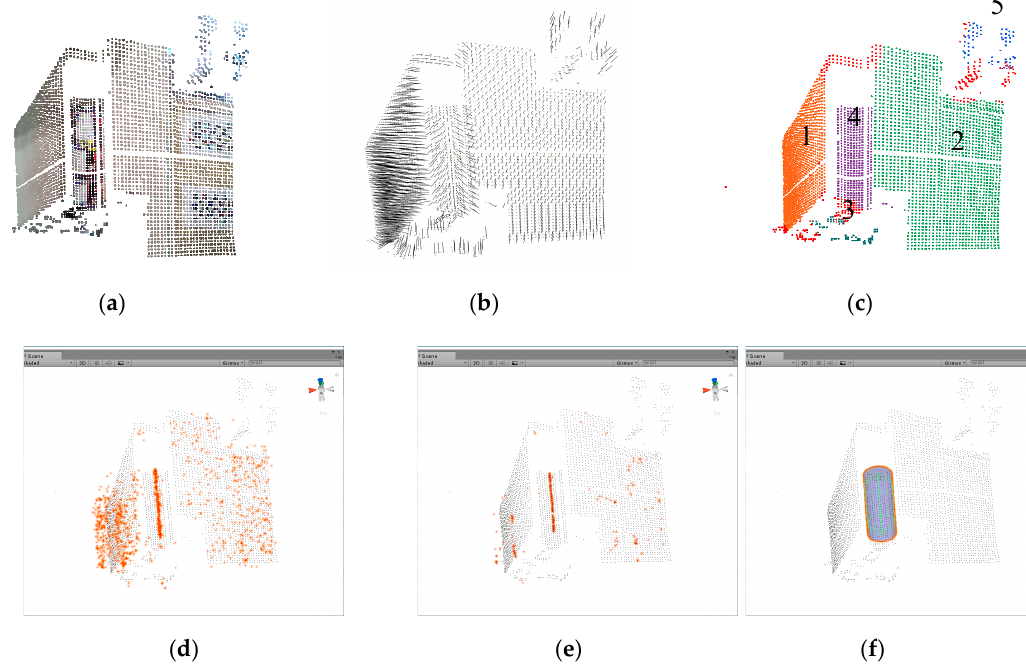
Figure 24. Pre-processing for the Hough transform and fast cylinder matching method using random sample consensus (RANSAC): ( a ) uniformized data; ( b ) normal estimation; ( c ) segmentation; ( d ) center line estimation; ( e ) filtered center line estimation; and ( f ) cylinder estimation. Table1. Theresult(Figure24)oftheexistingmethodandfastcylindermatchingmethodusingRANSAC. Hough Transform